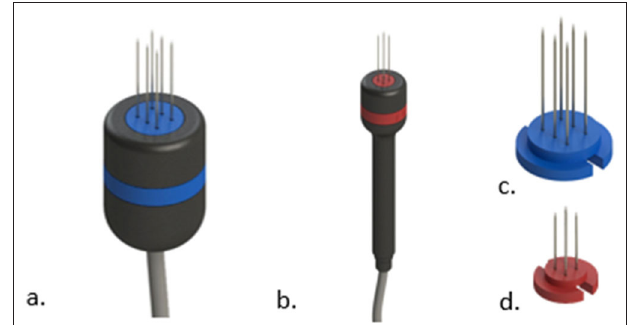
FIGURE 11 | Examples of handles with disposable needles. In (a) the handle for the disposable shown in (c) . In (b) the handle for the disposable shown in (d)